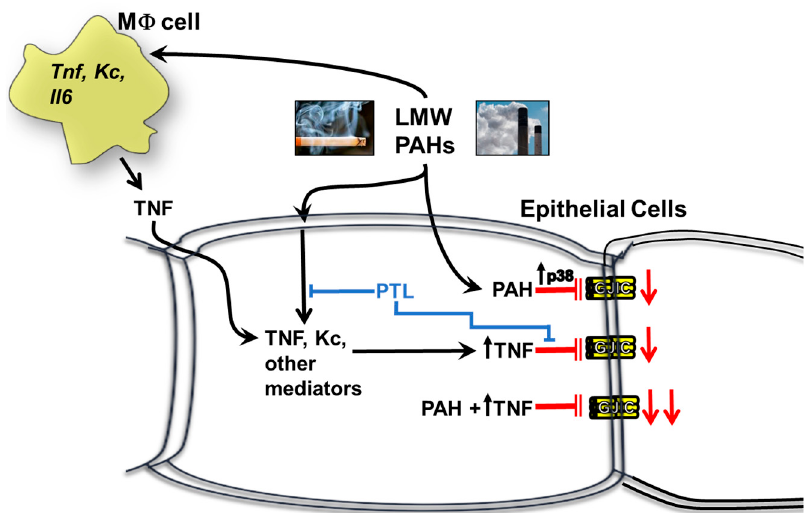
Figure 11. A schematic demonstrating the effects of inflammation on GJIC. PAHs activate MAP kinase pathways, such as p38 MAP kinase and inflammatory mediator pathways, such as cytokines (TNF, KC, and others). Some of these pathways then lead to the inhibition of GJIC. Blue indicates inhibition with PTL. Red indicates inhibition of gap junctions. M Φ , macrophage; PTL, parthenolide; p38, p38 MAP kinase.